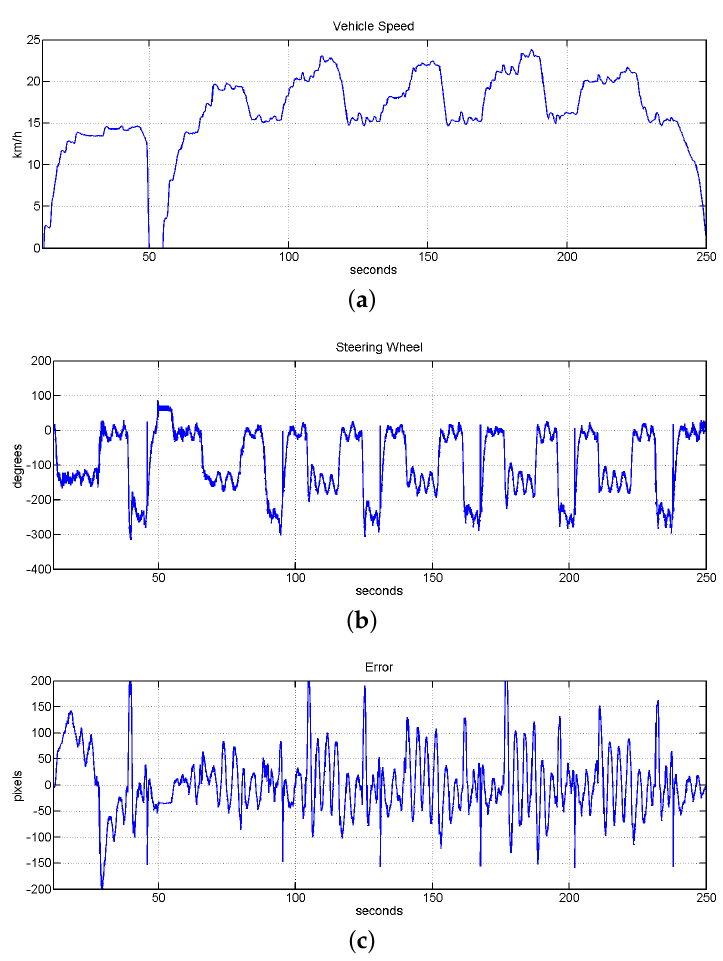
Figure 25. Evolution of the system with the speed assistance and the autonomous driving system working together. It is also shown the response of the system when a emergency stop is detected and done. ( a ) Vehicle speed evolution; ( b ) evolution of the steering wheel; ( c ) evolution of the error measured in pixels. The value of RMSE for this test is equal to 8.4839